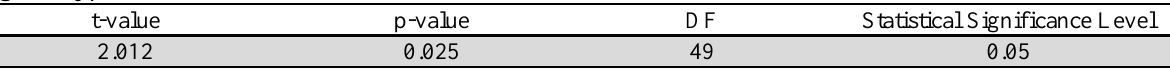
Eighth hypothesis at 95% confidence level t-value p-value